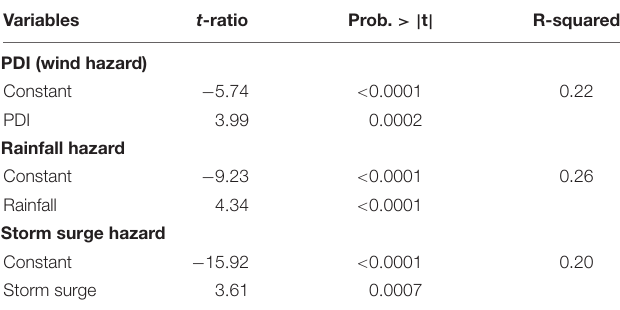
TABLE 1 | Individual Standard Least Squares regression (S-LSR) models to explore the relationship between normalized damages ( N Dam . ) caused by TCs in Hong Kong and different TC parameters (i.e., PDI, rainfall, and storm surge).